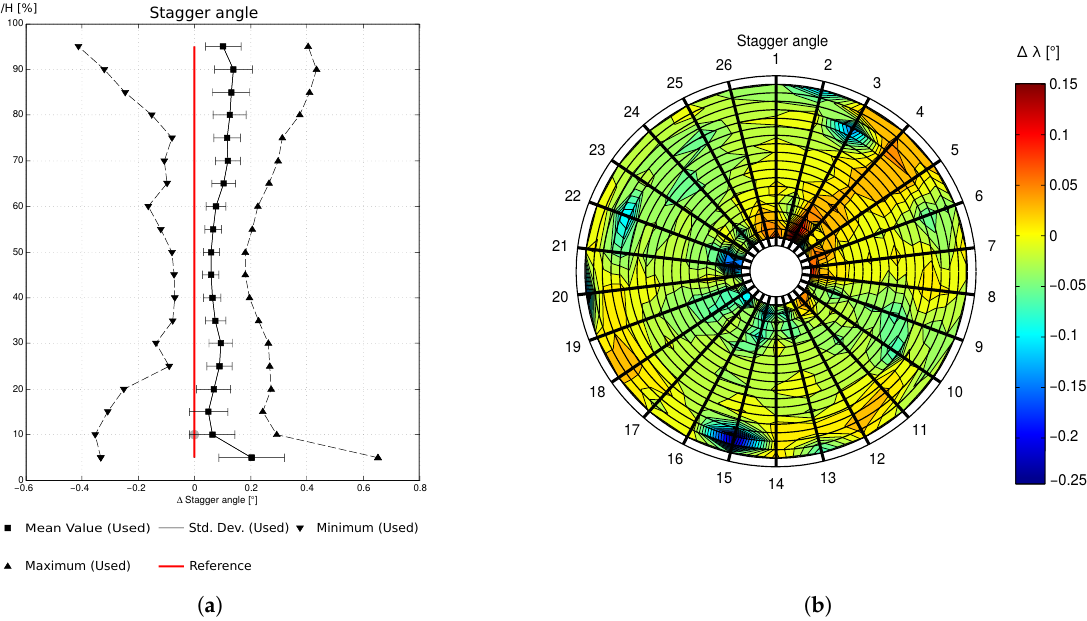
Figure 1. Geometric variances of BLISKs (blade-integrated-disks). ( a ) Variation of stagger angle for 10 BLISKs; ( b ) Circumferential rotor blade stagger angle distribution λ on BLISK No.